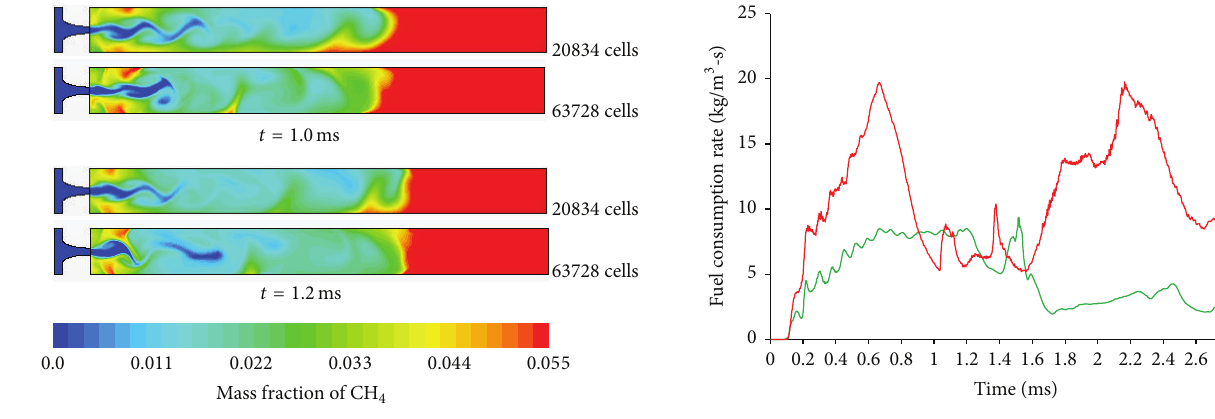
Figure 4: Methane mass fraction levels for two different grids for methane mixture in the CVC chamber using DRM19 reaction mechanism. Figure 5: CVC chamber-integrated fuel consumption rate for propane-air mixture, predicted using 4-step global reaction mecha- nism and detailed reaction mechanism.